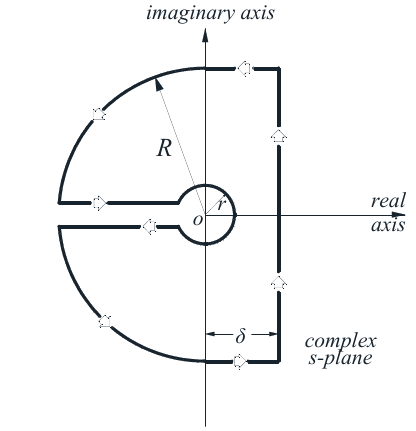
Figure 3. Contour integral of the inverse Laplace transform.